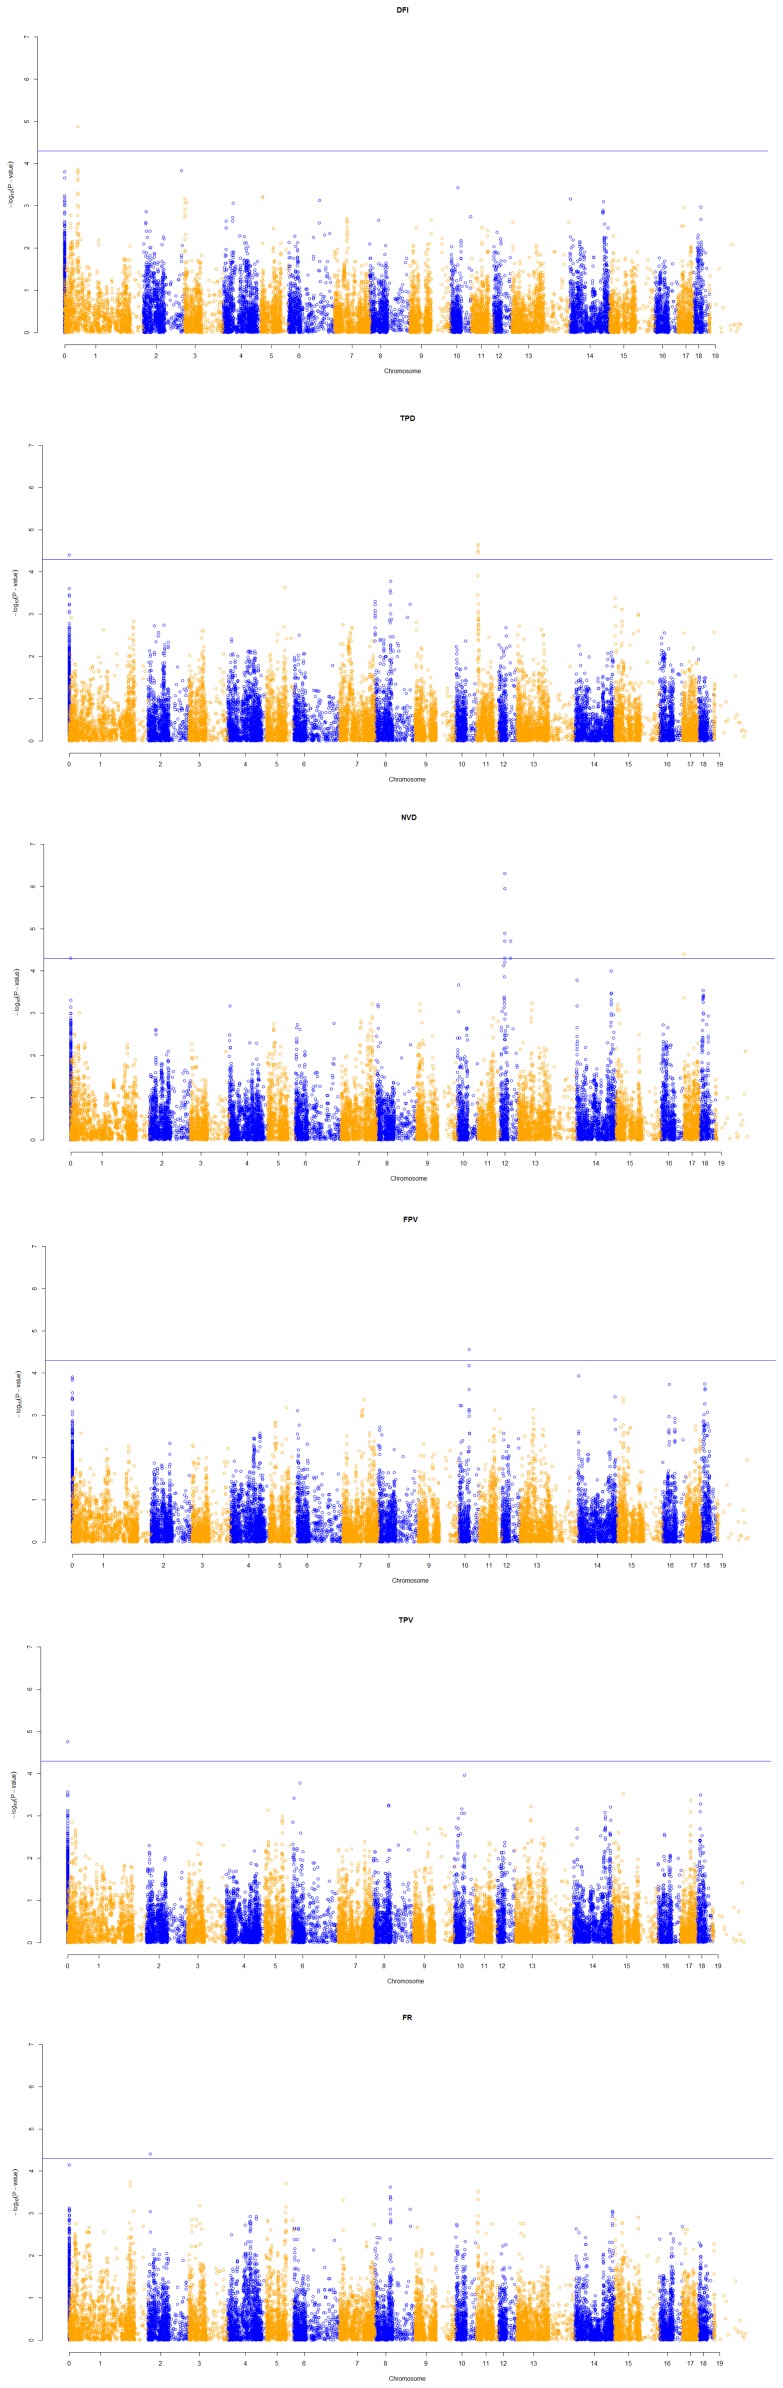
Manhattan plot showing association with feeding behavior traits for all the SNPs.The horizontal line indicates genome-wide significant threshold. On vertical, Manhattan plot for total daily feed intake (DFI), total time spent at feeder per day (TPD), number of visits to the feeder per day (NVD), time spent to eat per visit (TPV), mean feed intake per visit (FPV), and mean feed intake rate (FR), respectively. Chromosome 19 stands for X chromosome. Chromosome 0 stands for unmapped SNPs.